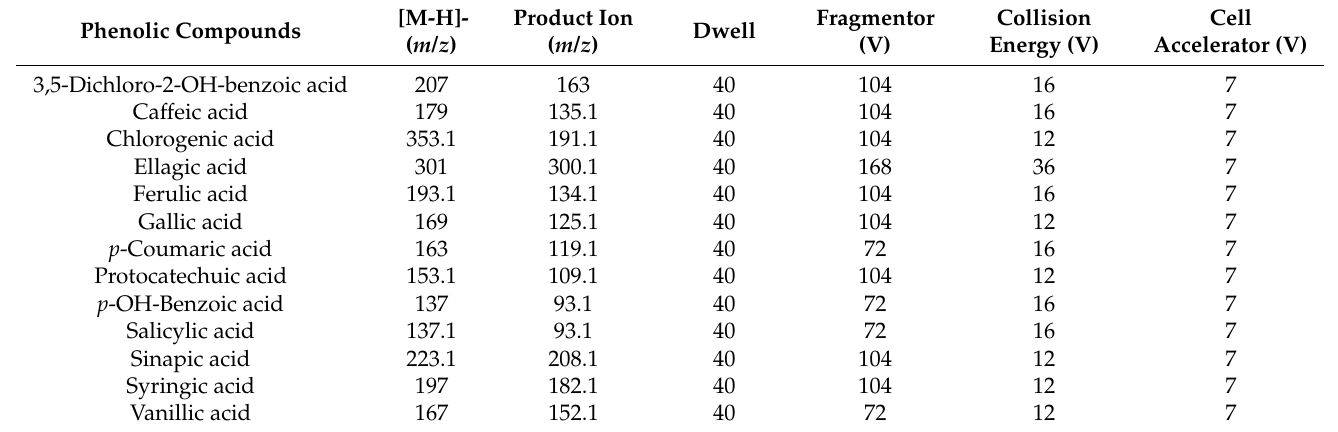
Table 7. Related MS data of investigated phenolic acids in the UPLC analysis.